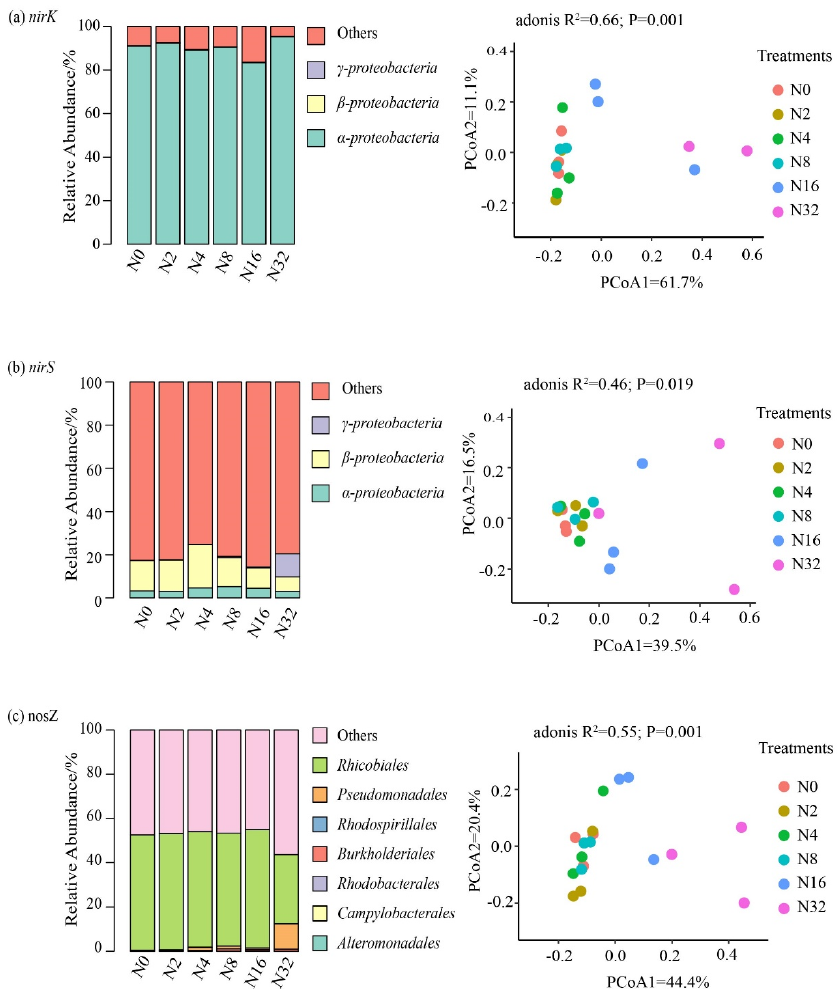
Figure 4. The relative abundances of nitrifier community compositions and principal coordinates analysis (PCoA) based on the Bray–Curtis distance. ( a ) nirK , ( b ) nirS , ( c ) nosZ . N0 is the control (0 g N ∙ m − 2 ∙ yr − 1 application), N2 is the 2 g N ∙ m − 2 ∙ yr − 1 application, N4 is the 4 g N ∙ m − 2 ∙ yr − 1 application, N8